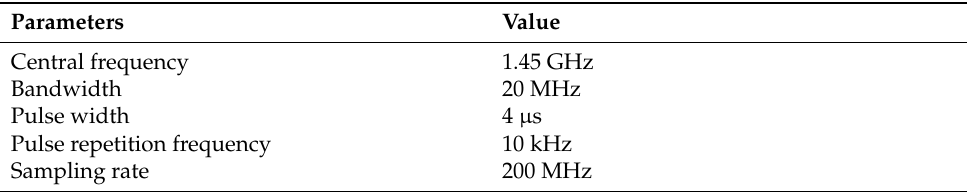
Table 3. Parameters of experimental data.